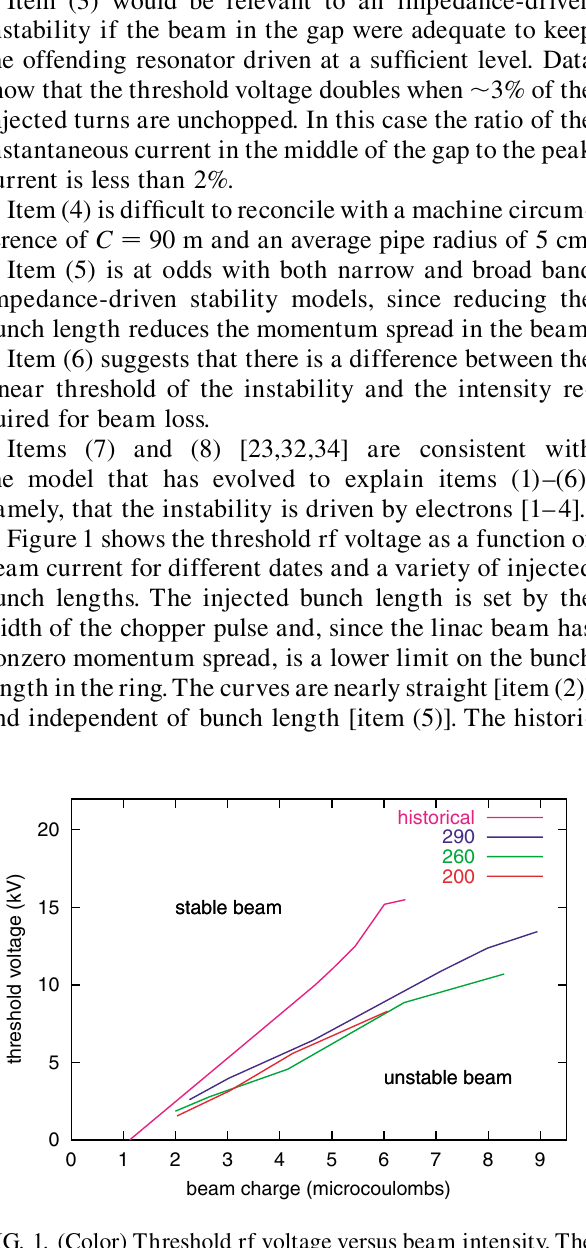
FIG. 1. (Color) Threshold rf voltage versus beam intensity. The threshold rf voltage is the smallest rf voltage for which the beam is stable. The historical curve represents the situation before the direct H (cid:7) injection upgrade and the extended run during 2001. Threshold curves near the end of the 2001 run for injected bunch lengths of 200, 260, and 290 ns are shown for comparison.